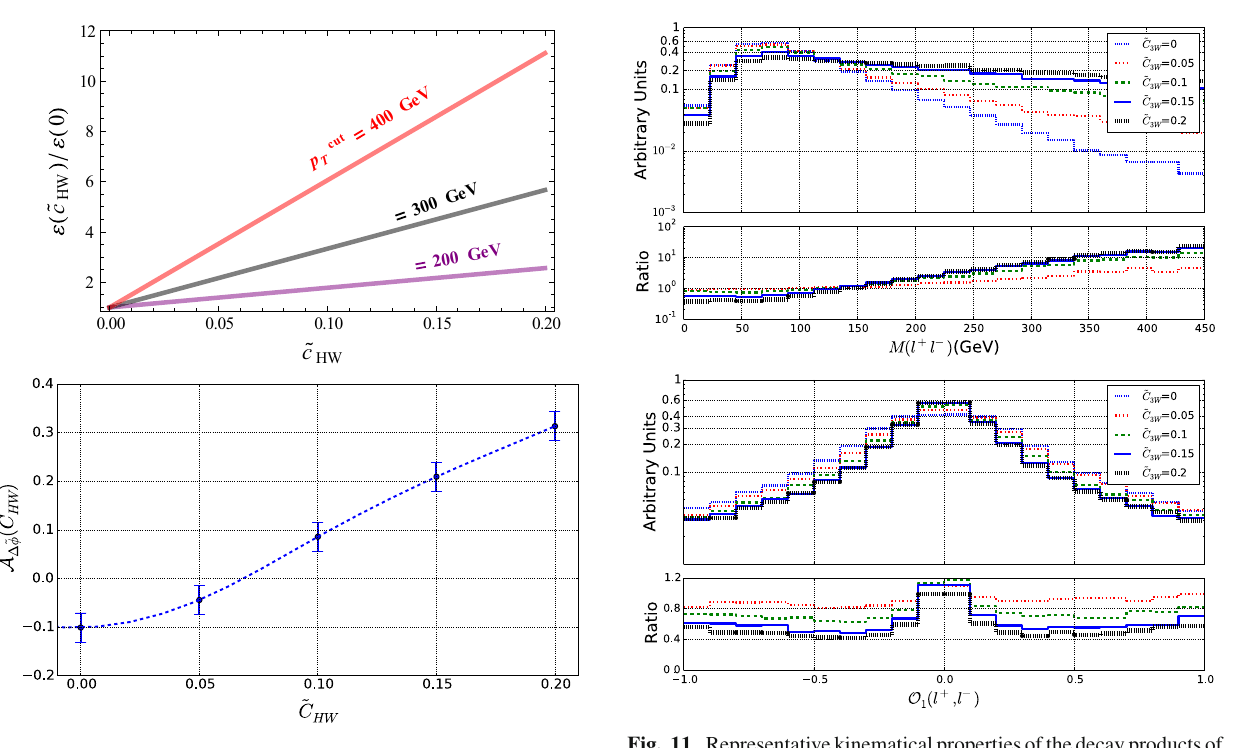
Fig. 10 Same as in Fig. 6 but for VBF Higgs-boson production and the observables considered in Sect. 6.2